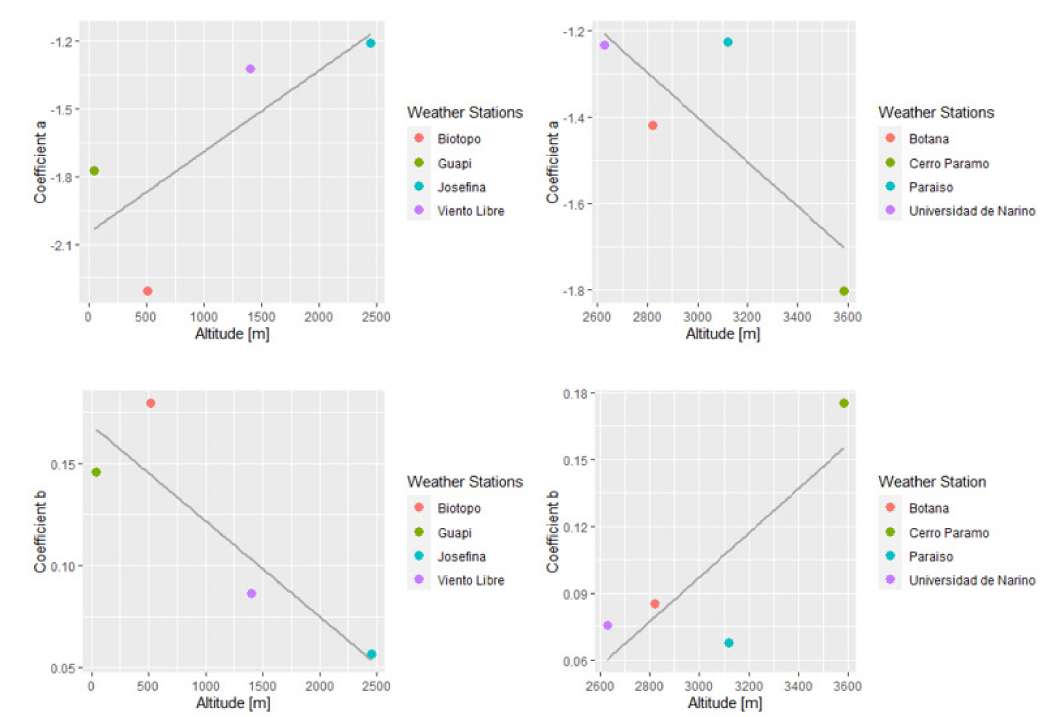
Figure 11. Coefficients a and b empirical model–altitude relation in the proposed